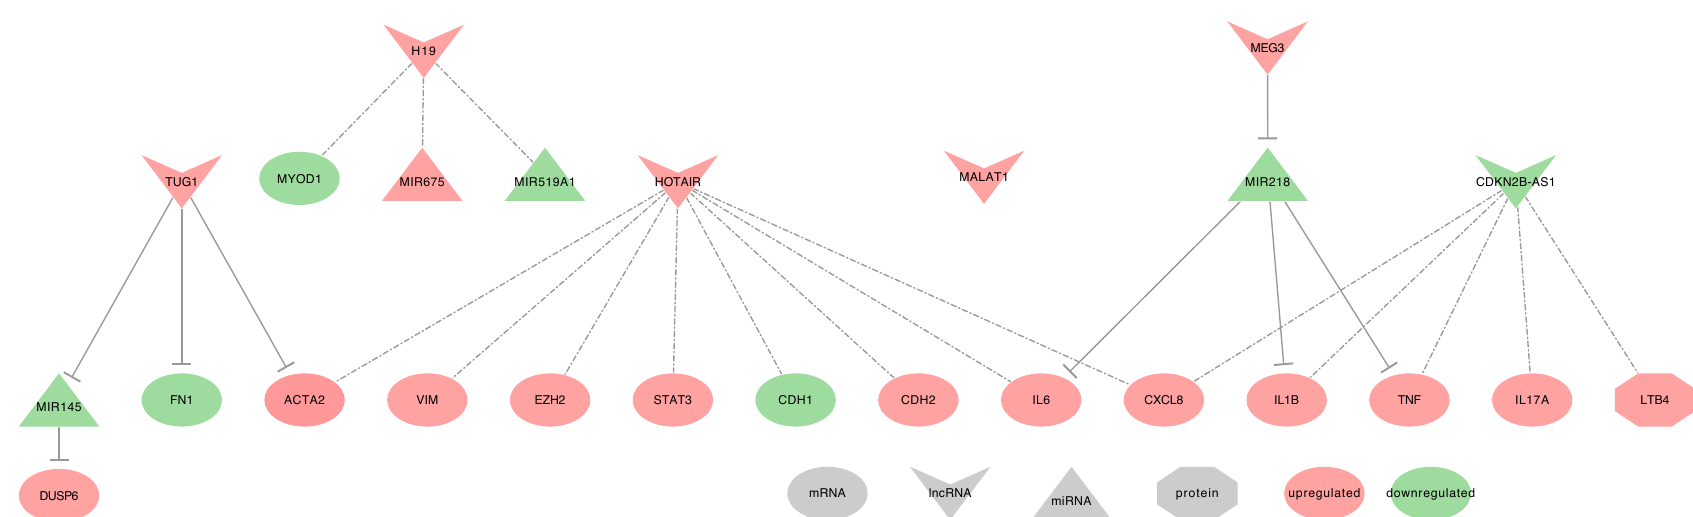
Figure 4. The selected eight lncRNAs in Chronic Obstructive Pulmonary Disease (COPD): A network of lncRNA-miRNA-Protein interactions. Upregulated molecules are in green. Downregulated molecules are in red. Up or down-regulated molecules are in purple. Shape definitions are in grey. Gray arrows target the activated molecules. T-ended lines target the inhibited molecules. Square-ended lines represent a binding between molecules. Dashed-dot lines represent an association with unknown